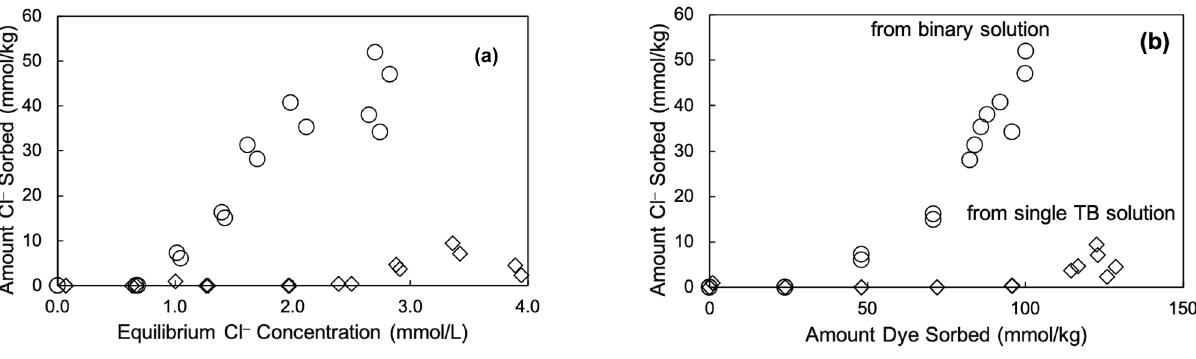
Figure 7. Sorption of counterion Cl − from single and mixed dye solutions: ( a ), and amount of Cl − sorbed vs. dye sorbed ( b ).